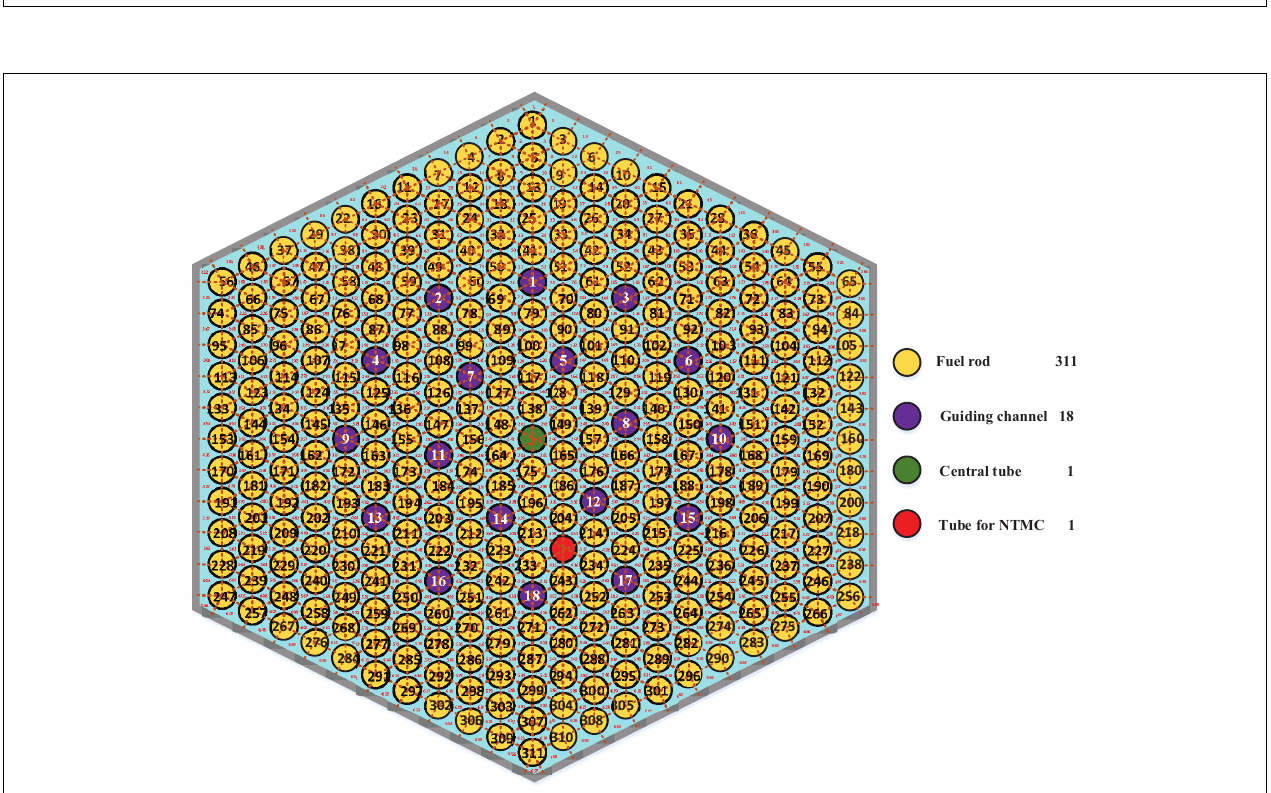
FIGURE 2 | VVER1000/446 core fuel assemblies’